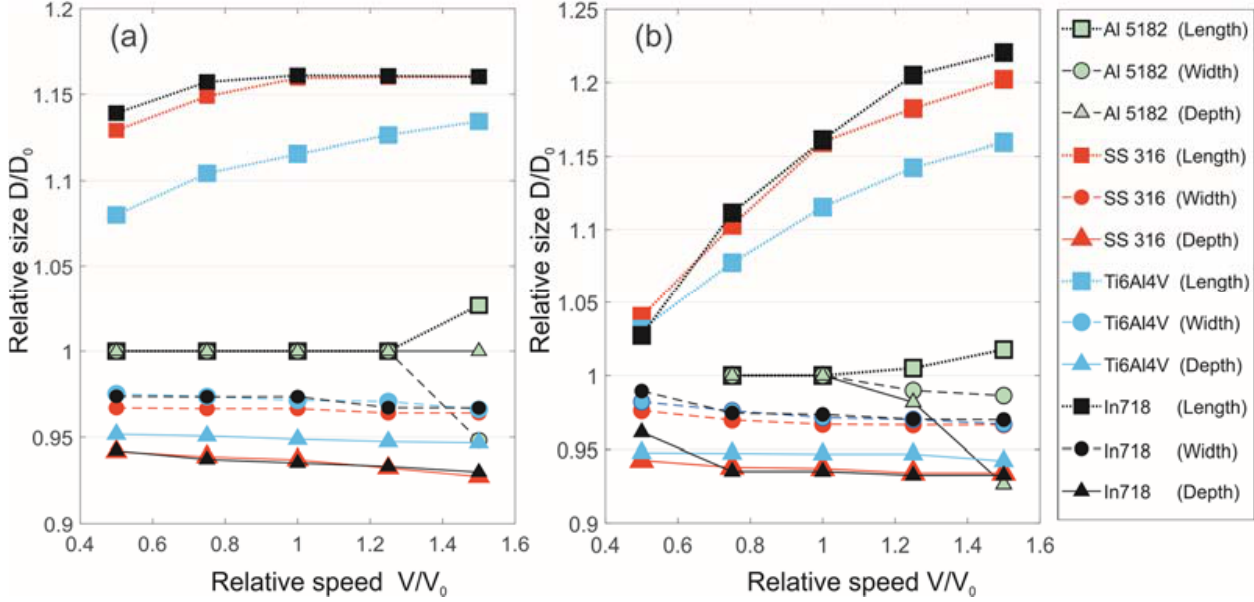
Figure 5. Dependence of the relative melt pool size with a change in the scanning speed (the unit is taken as the speed V 0 ): ( a ) at constant power, ( b ) at constant linear energy.